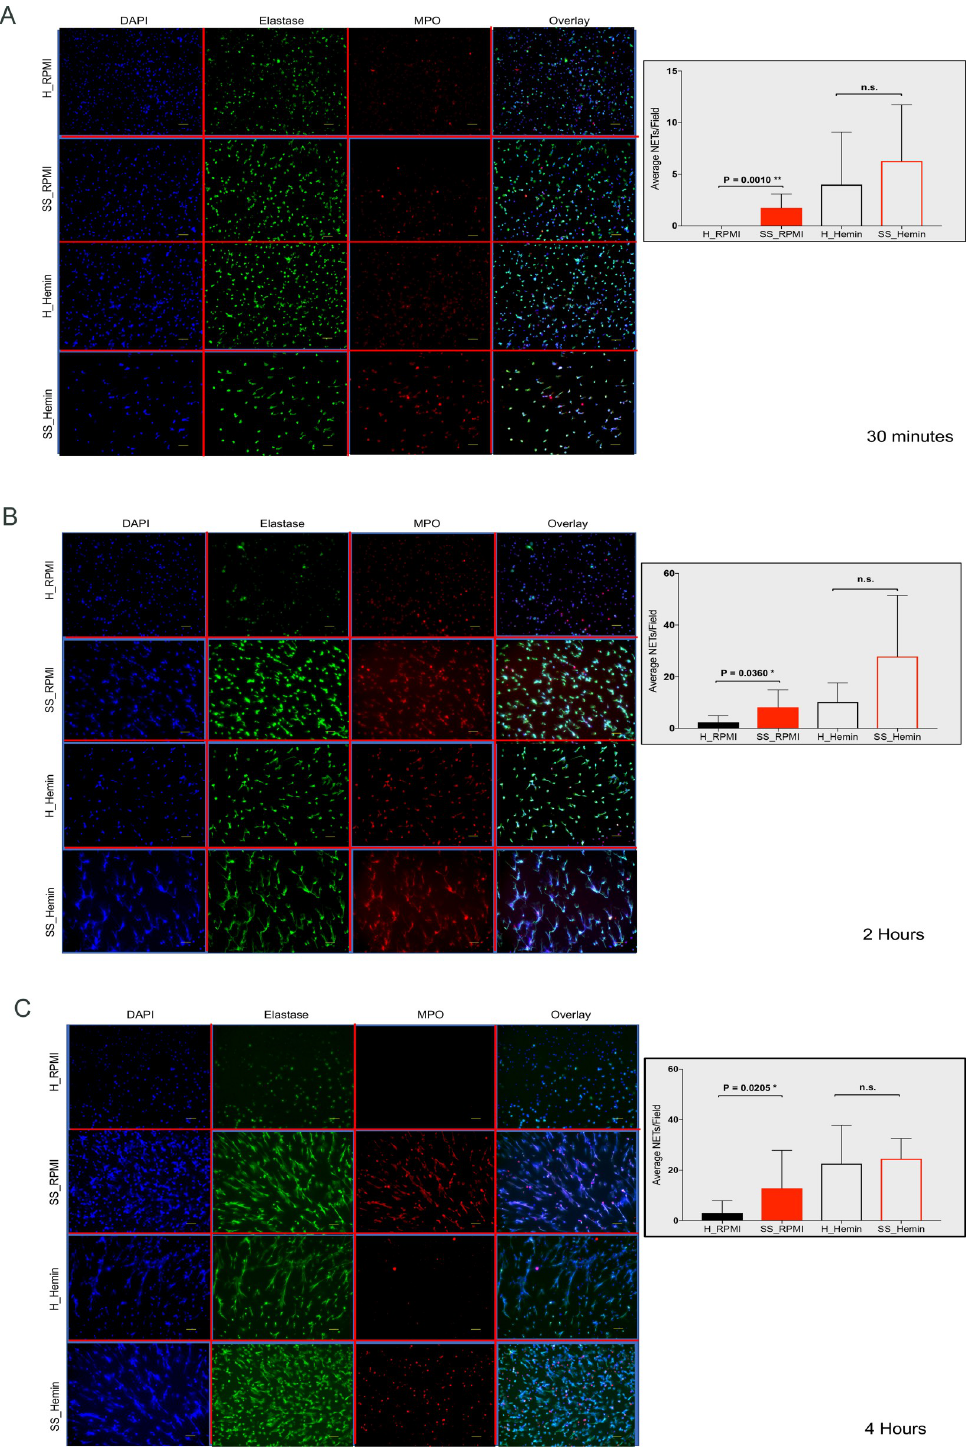
Fig 2. Ex vivo, untreated neutrophils from SCD patients are efficient at producing NETs in the absence of a specific trigger. Representative immunofluorescence microscopy data and NETs count at 30 minutes (A), 2 hours (B) and 4 hours (C). Scale bar is 50 μ m. Purified and rested neutrophils from healthy donors (H) and from SCD patients at steady state (SS) were incubated with RPMI or 20 μ M hemin. Neutrophils were fixed with 4% PFA and then stained for elastase, MPO and DNA. NETs production was counted in at least 10 acquired fields and shown as average NETs per field ± S.D. Significance was calculated with an unpaired Mann-Whitney test. https://doi.org/10.1371/journal.pone.0226583.g002 PLOS ONE | https://doi.org/10.1371/journal.pone.0226583 December23, 2019 6 /